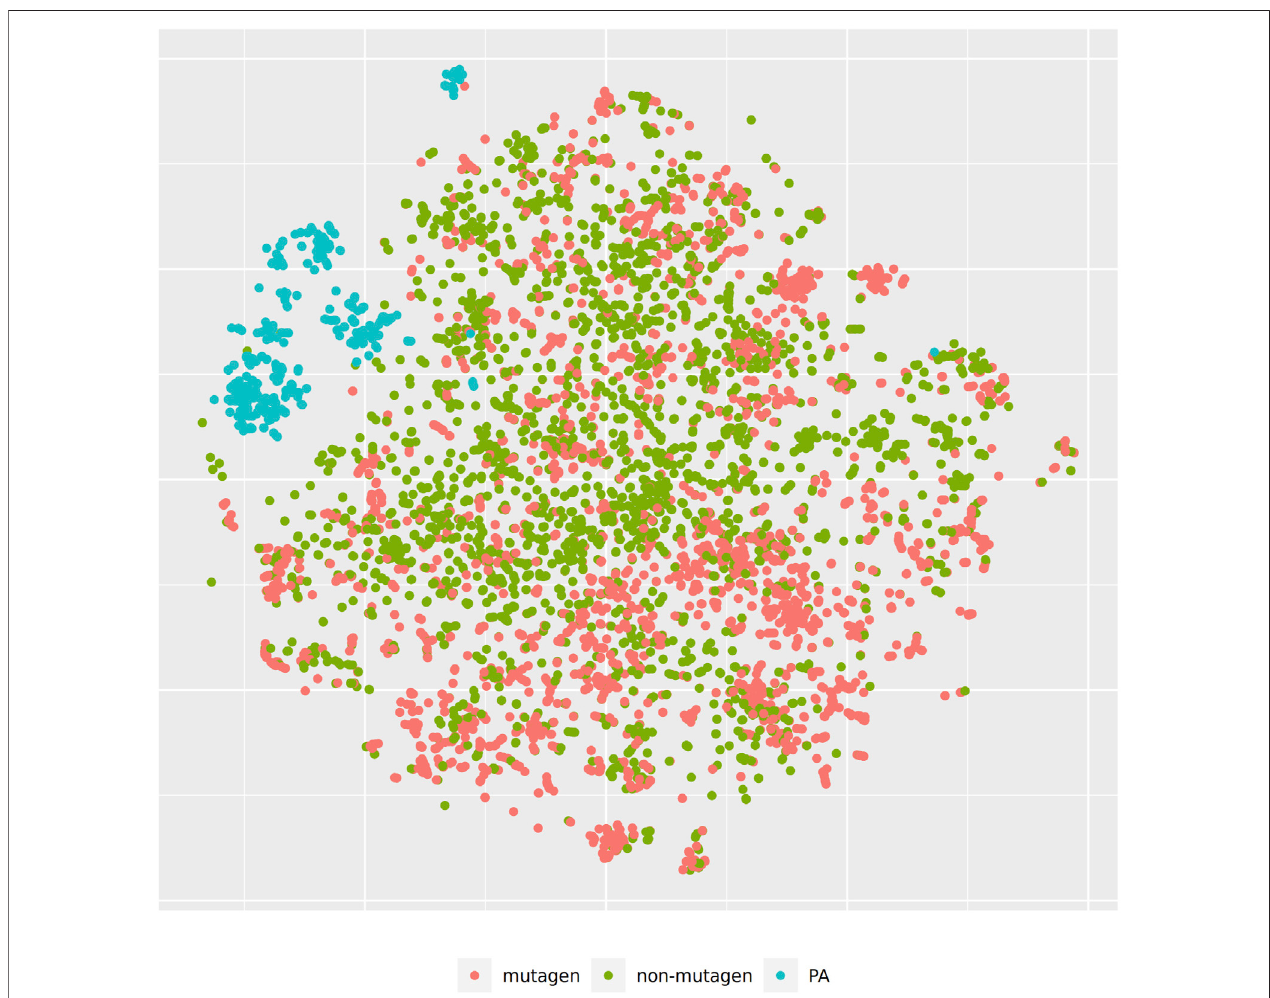
FIGURE 3 | t-SNE visualization of mutagenicity training data and pyrrolizidine alkaloids (PA) in MP2D space.